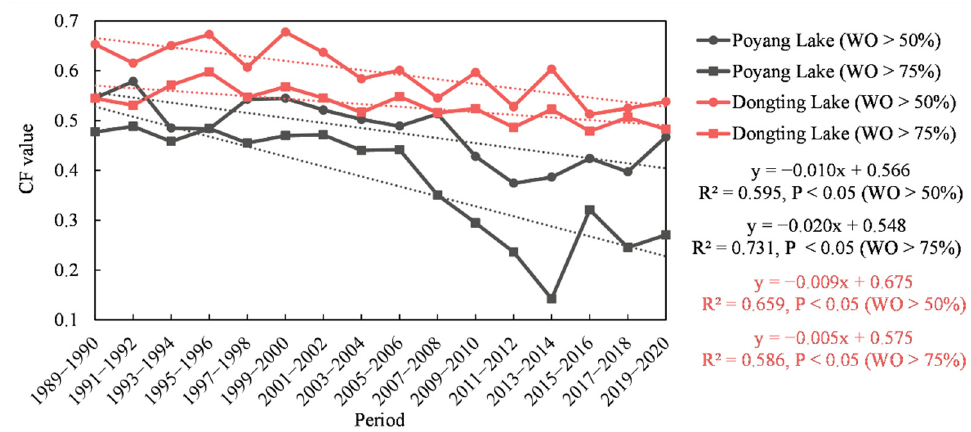
Figure 8. Time series of CF values in Poyang Lake and Dongting Lake from 1989 to 2020.